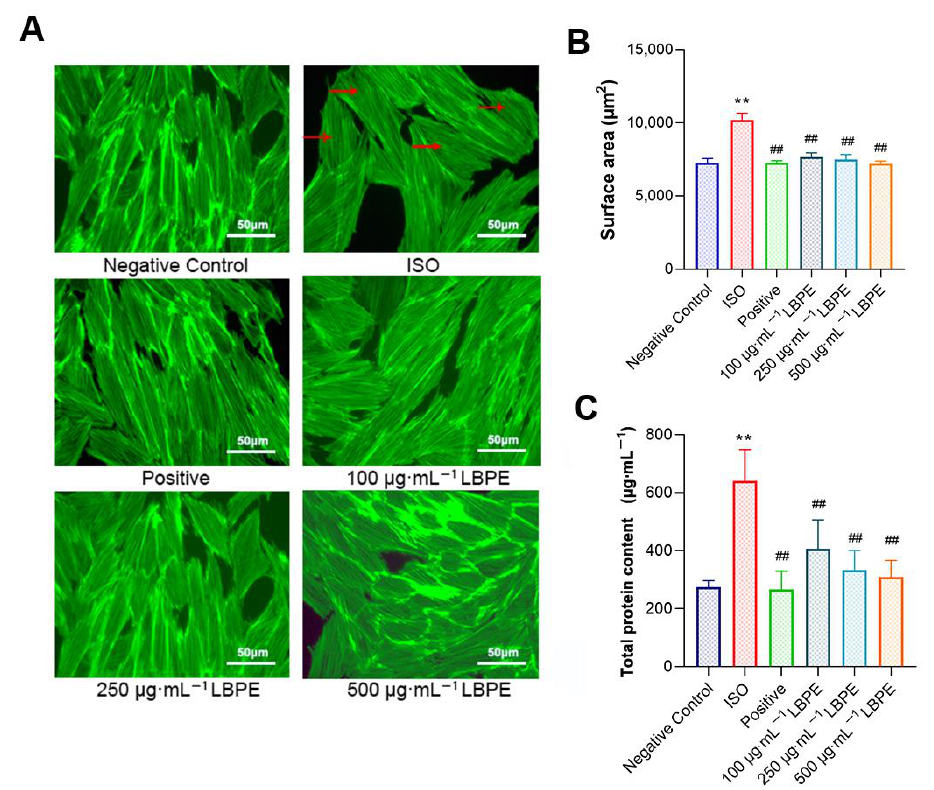
Figure 2. Effects of LBPE on ( A ) the morphology using phalloidin staining (×400), ( B ) surface area and ( C ) total protein content of H9c2 cardiomyocytes (n = 6). “ → ” indicates that the cells lose their spindle shape. ISO group vs. negative control group, ** p < 0.01. Positive and LBPE groups vs. ISO group, ## p < 0.01.